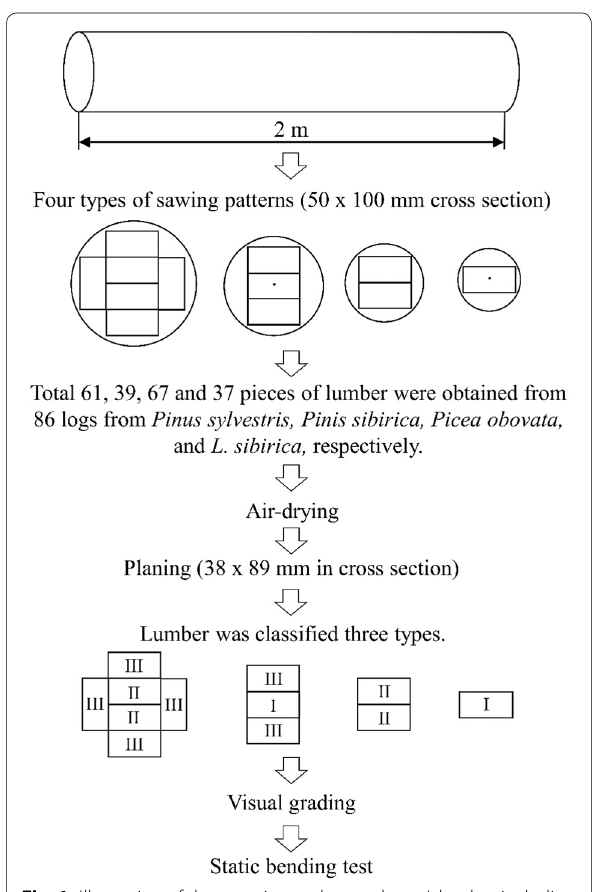
Fig. 1 Illustration of the experimental procedures. I, lumber including pith at almost‑center position in cross‑section; II, lumber obtained near the pith (sometimes including pith on the surface area of the lumber); III, lumber obtained from outer part of the logs (without